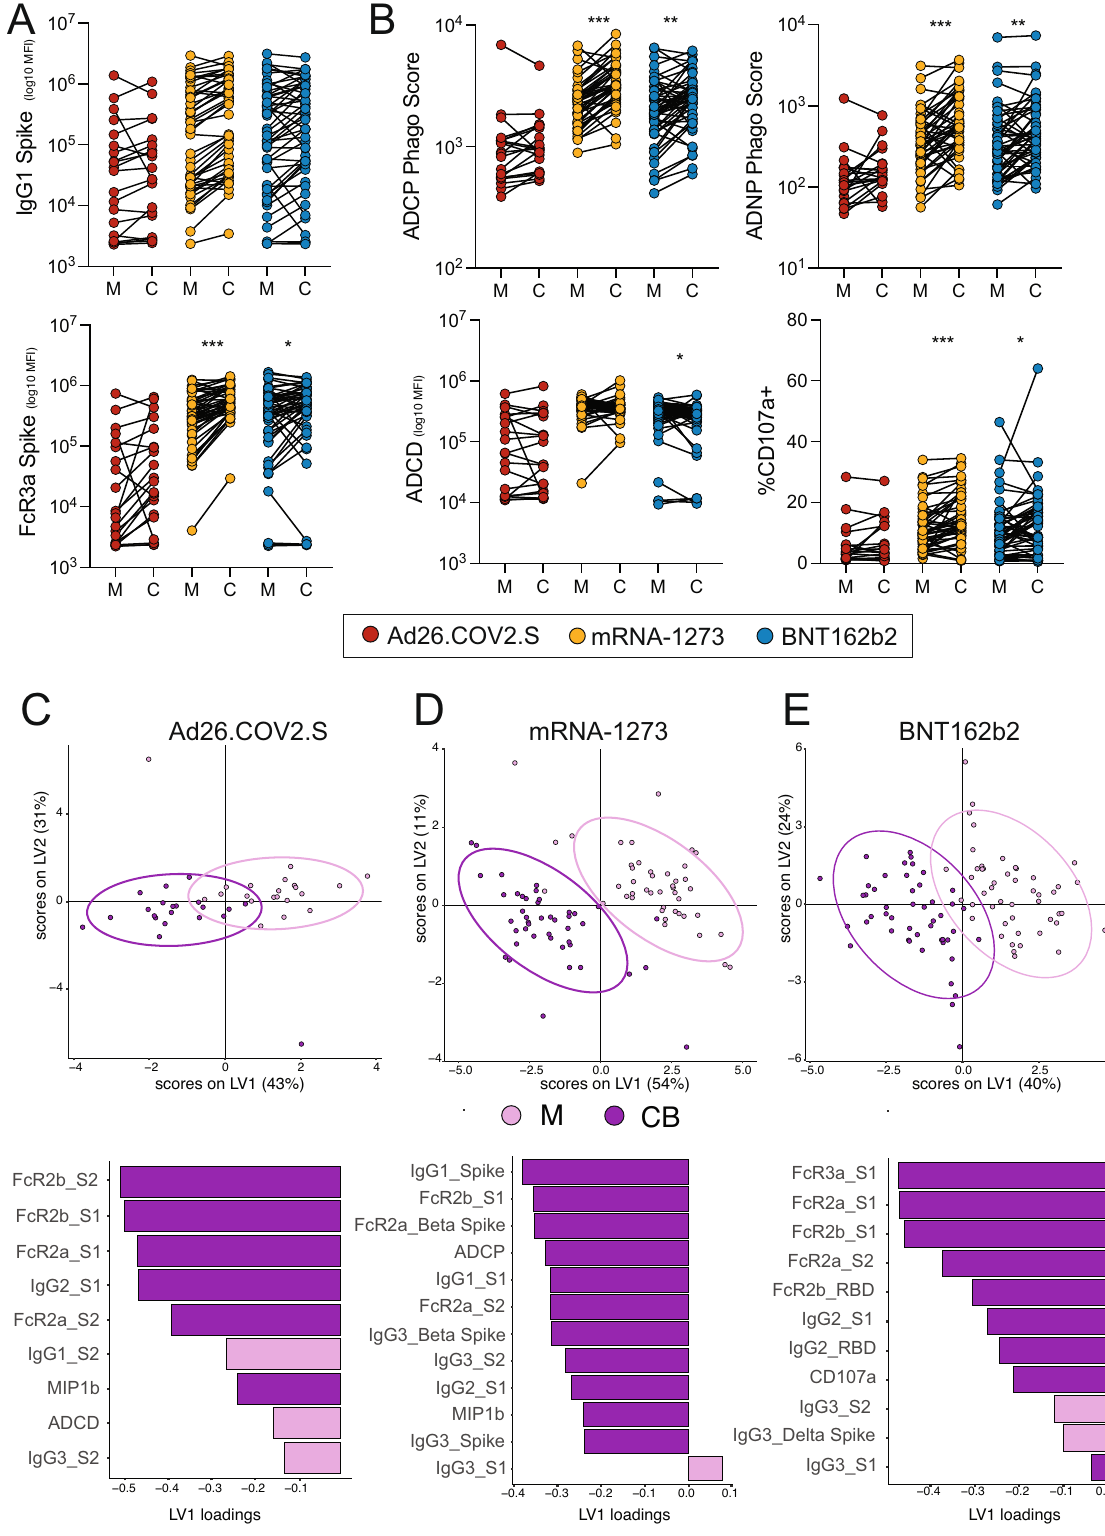
second trimester vaccination. Whether higher antibody transfer ratios observed for fi rst trimester COVID-19 vaccination are